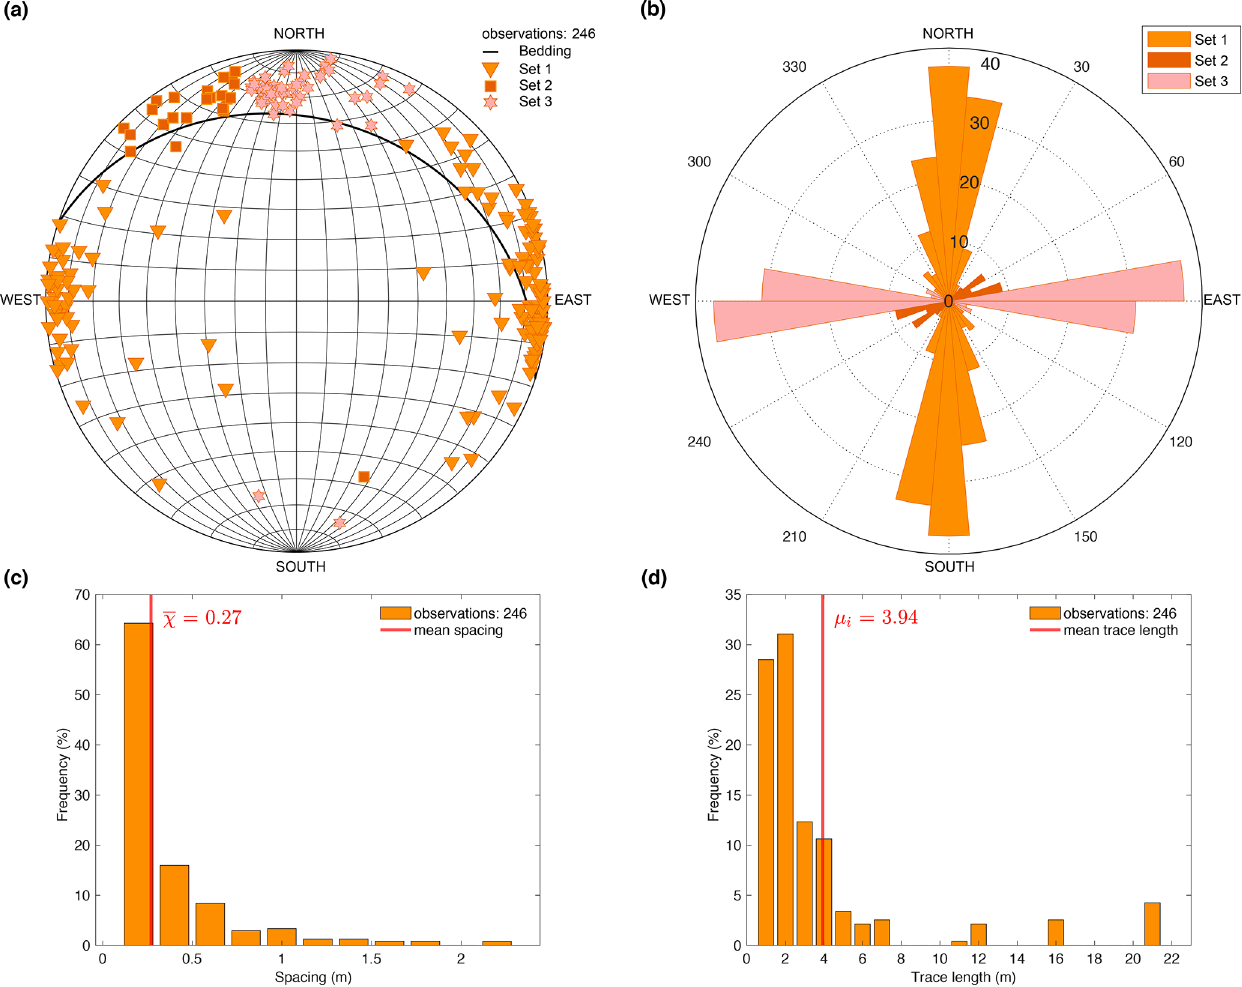
Figure 6. Results of all scanline investigations at the quarry in Hönnetal: (a) stereogram of measured discontinuity sets and a (b) rose diagram of rotated discontinuity orientations according to the bedding layer in panel (a) to a horizontal position, (c) discontinuity spacing diagram, and (d) discontinuity trace length